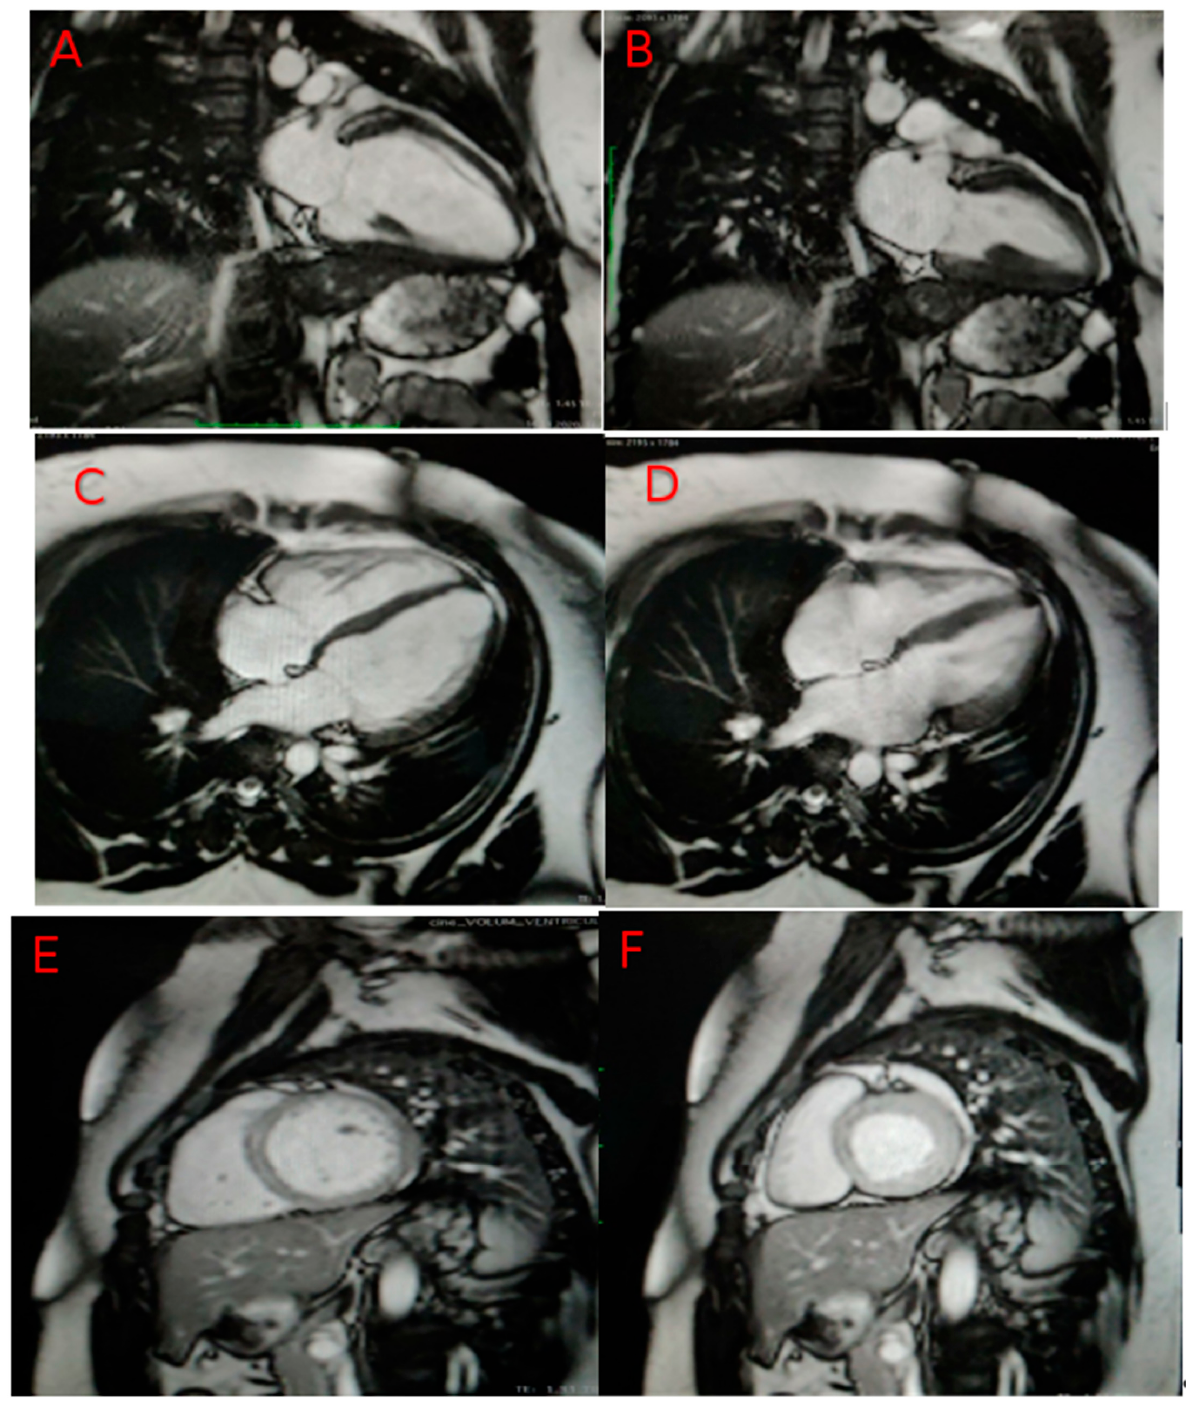
Figure 1. MRI confirms LV dilated cardiomyopathy. In images ( A ) (long axis 2 chambers LV-diastole), ( B ) (long axis 2 chambers LV-systole ( C ) (long axis 4 chambers LV-diastole), ( D ) (long axis 4 chambers LV-systole), ( E ) (short axis LV- diastole), ( F ) (short axis LV-systole), the LV is slightly dilated (end-diastolic volume index-EDVi 98 mL/m 2 —probably underestimated indexed value due to the patient’s weight, with systolic function around the lower limit of normal (LVEF 58%). Ventric-ular volumes: end-diastolic volume (EDV)—220 mL, end-systolic volume (ESV)—92 mL, stroke volume— 128 mL, ejec-tion fraction (LVEF: 58%, RVEF: